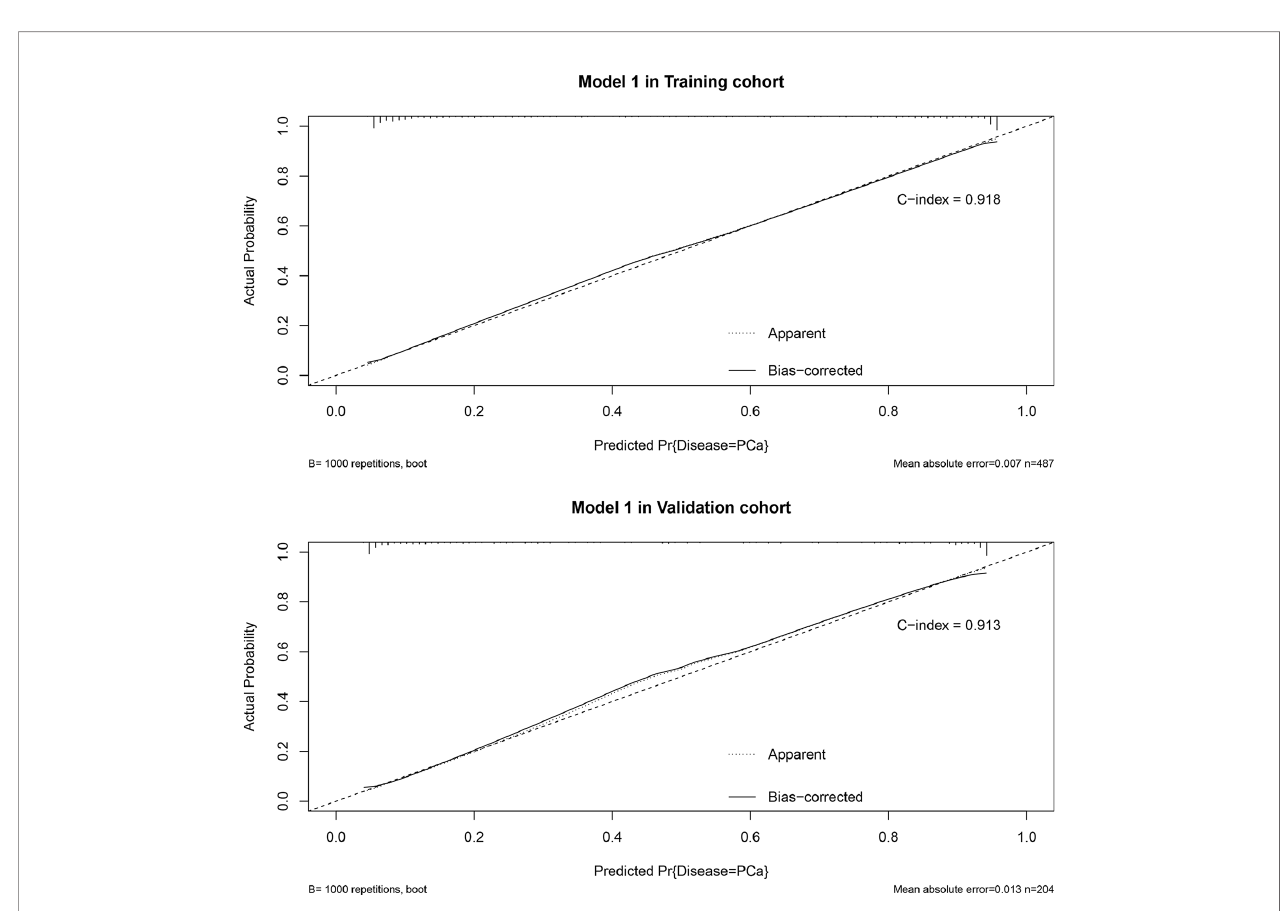
FIGURE 5 | Calibration plot in training cohort and validation cohort and predictive accuracy for PCa at initial biopsy based on model